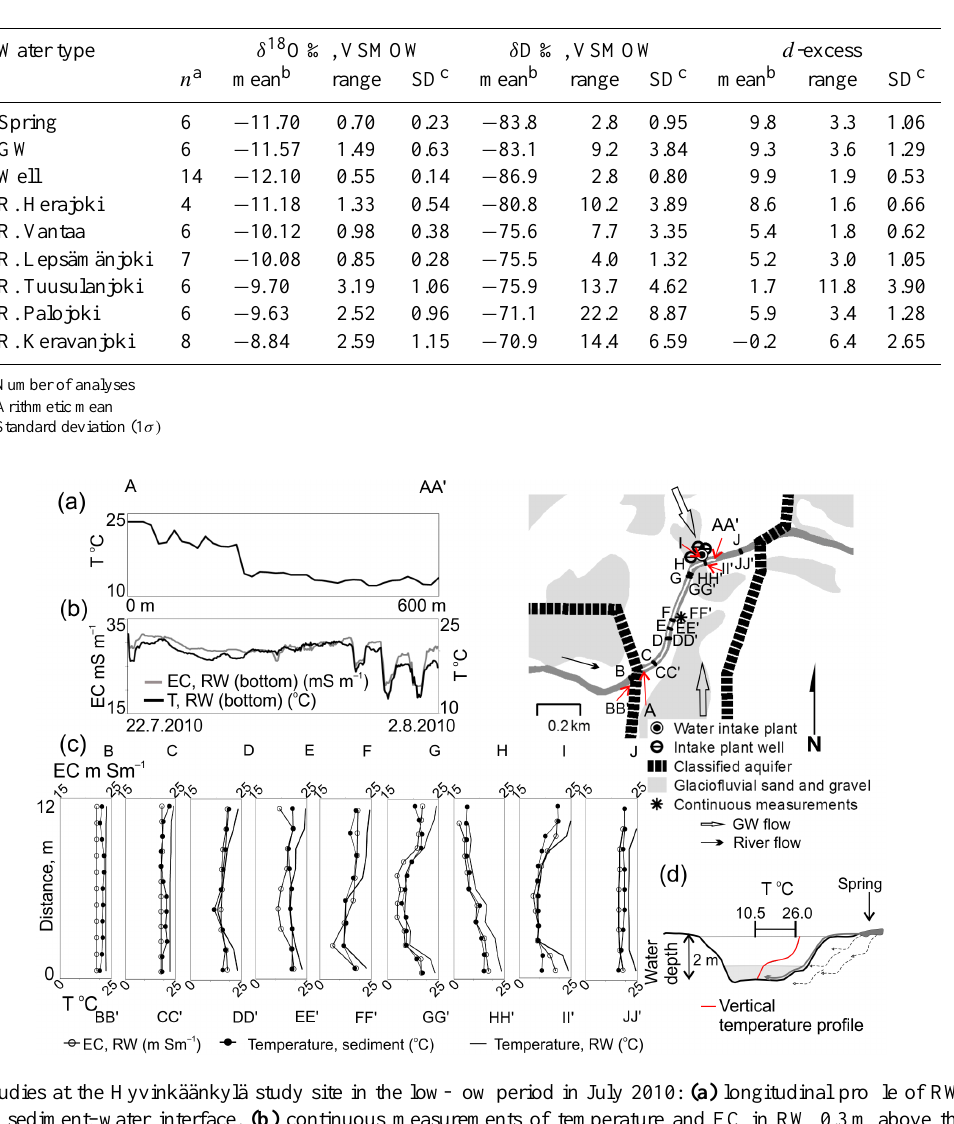
The EC values measured from upstream RW (0.22 mS m − 1 ) (cross section W–WW (cid:48) ) and natural GW (0.22 mS m − 1 ) (observation well, not shown in Fig. 7) were close to each other, whereas infiltration water (EC = 0.072 mS m − 1 ) used for artificial GW recharge deviated from these values. The lower EC values,